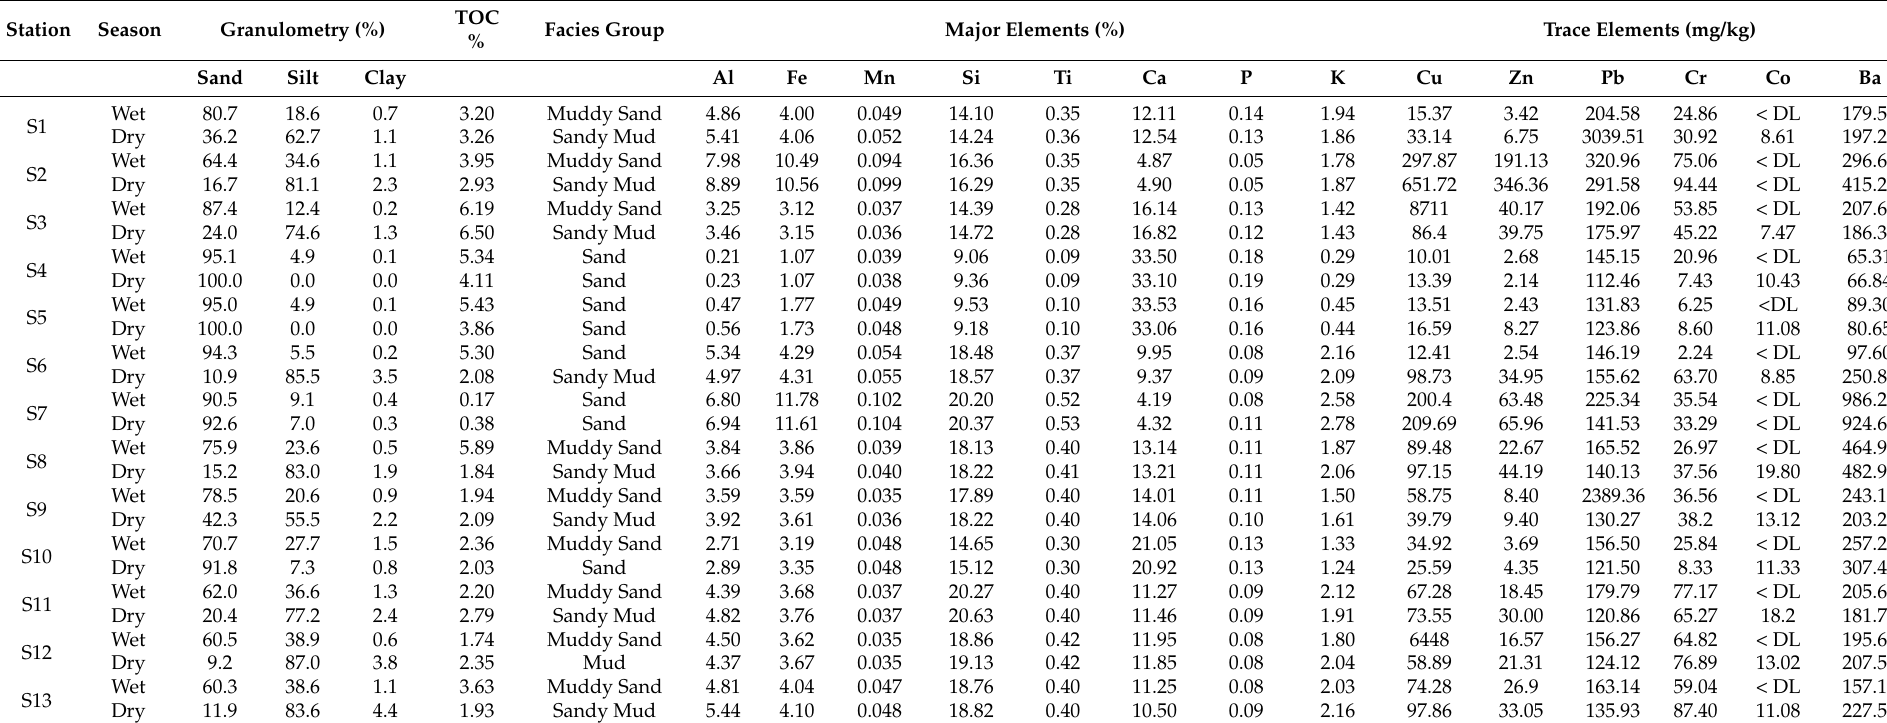
Table 3. Seasonal and spatial concentrations of the grain size fractions (%), total organic carbon (TOC; %), major elements (%), and trace elements (mg/kg).